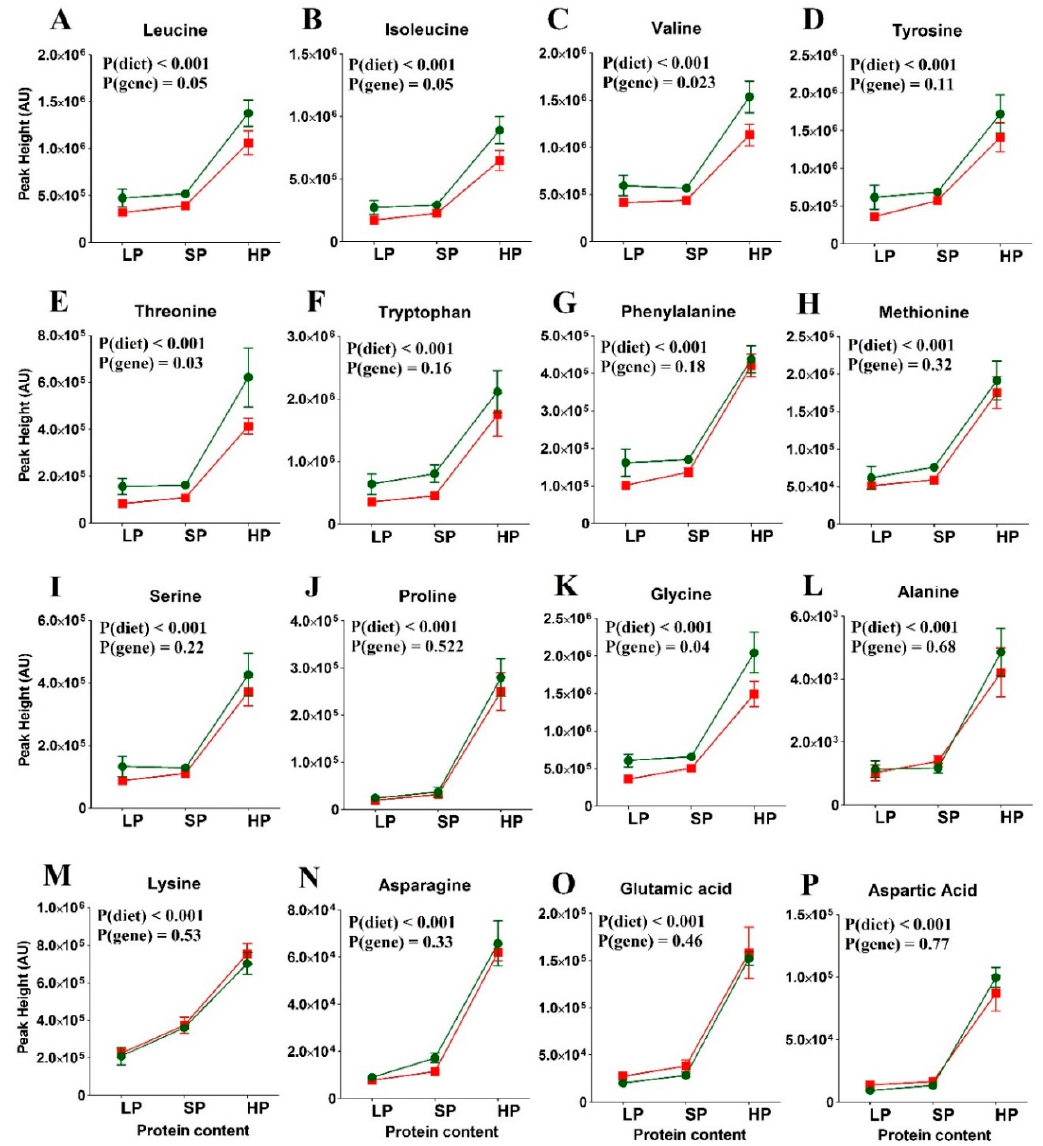
Figure 5. Plasma amino acid levels in SLC6A19 ko (red) and wt (green) mice on diets with low (LP), standard (SP), and high protein (HP) contents in the fasted state. Amino acids: (A) Leucine, (B), Isoleucine, (C) Valine, (D) Tyrosine, (E) Threonine, (F) Tryptophan, (G) Phenylalanine, (H) Methionine, (I) Serine, (J) Proline, (K) Glycine, (L) Alanine, (M) Lysine, (N) Asparagine, (O) Glutamic acid and (P) Aspartic acid. The error bars represent x ± SEM ( n = 5 per group). p -values were calculated by ANOVA comparing within-group and between-group variance of the diet effects (diet) and genotype effects (gene).